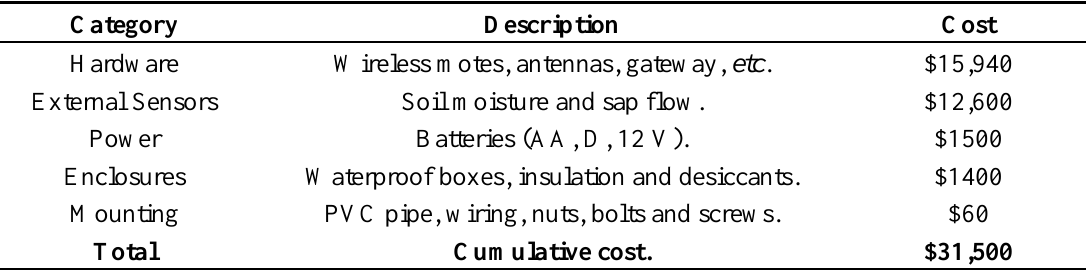
Table 7. Summary of the ASWP WSN physical